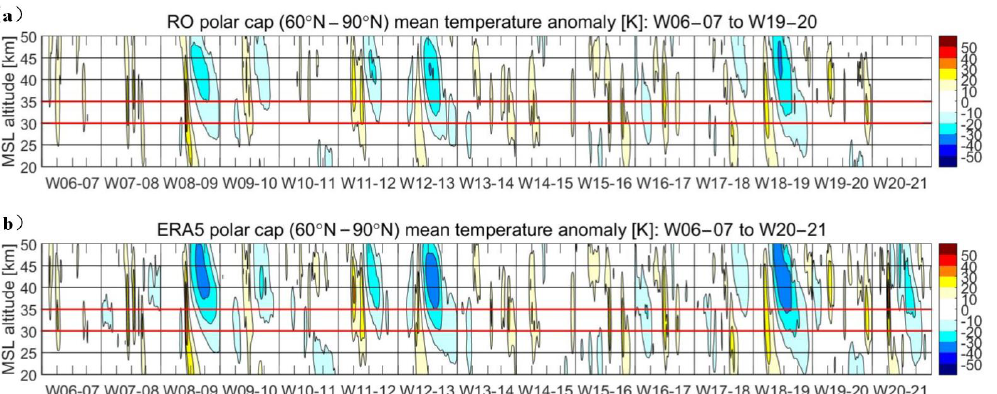
Figure 4. Temporal evolution of polar-cap-mean (60–90 ◦ N) daily mean temperature anomaly profiles from RO (a) and ERA5 (b) over four winter months each (December, January, February, March) for the winters from 2006–2007 (W06–07) to 2019–2020 for RO (W19–20) and to 2020–2021 for ERA5 (W20–21). The RO dataset did not yet cover the W20–21 time